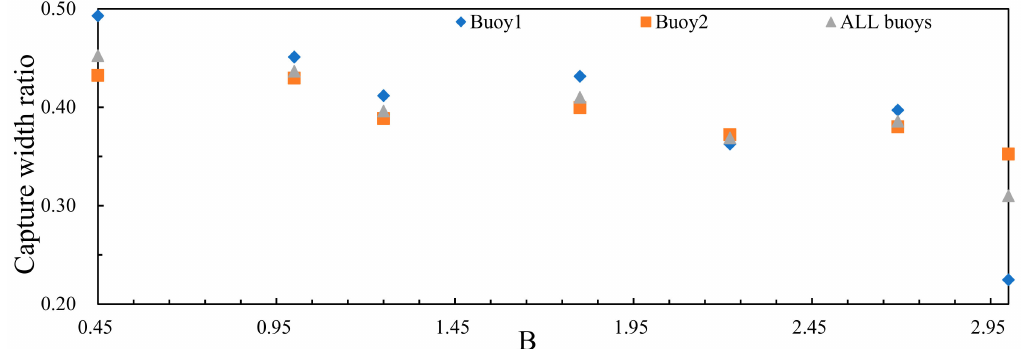
Figure 8. Curve of capture width ratio with aspect ratio.